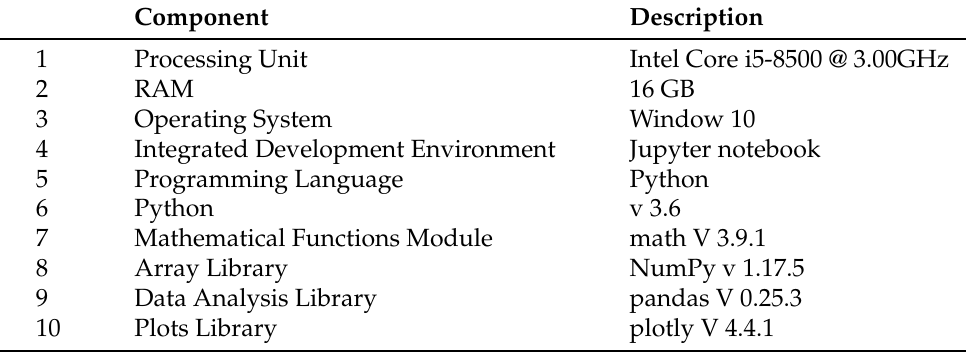
Table 2. Configuration of simulation